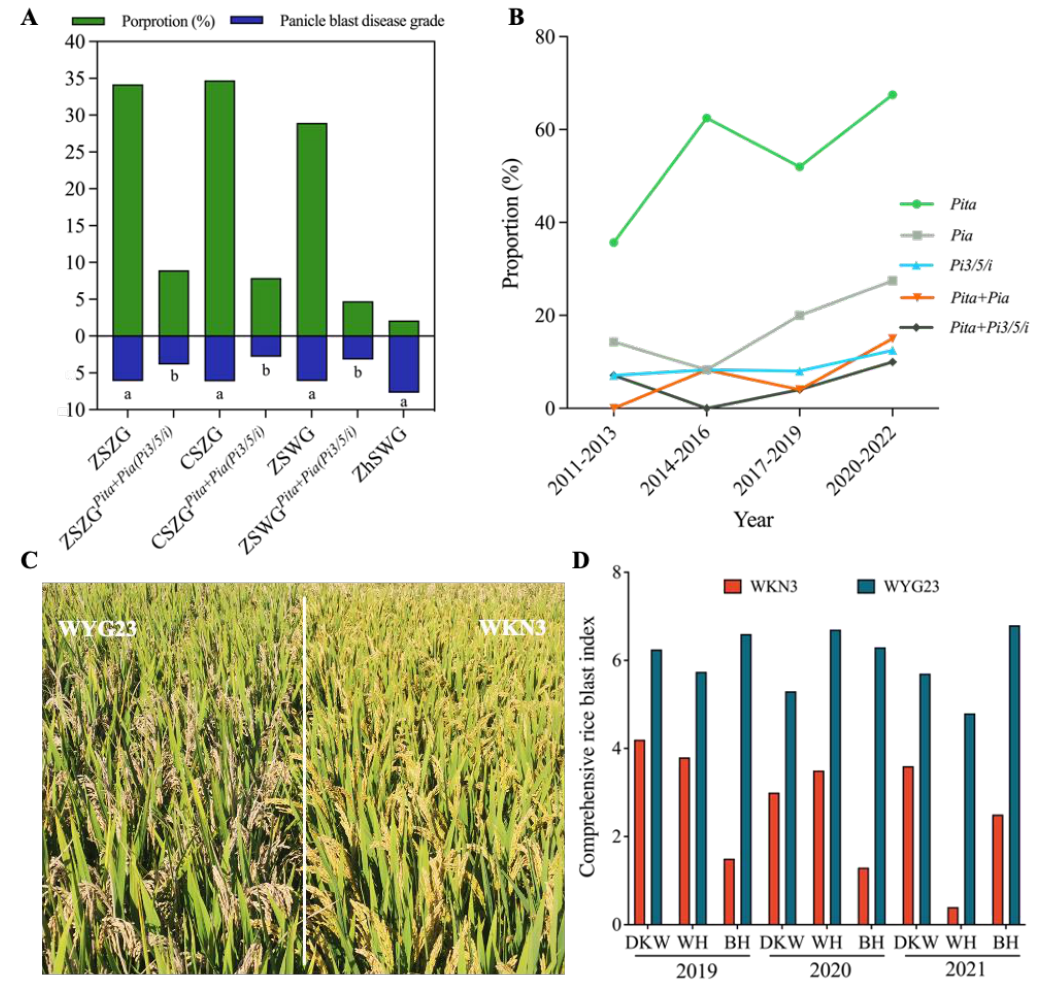
Figure 5. Application of core R genes and gene combinations in Jiangsu Geng varieties in recent years. ( A ) Application of Pita + Pia ( Pi3/5/i ) in varieties of different ecotypes tested for panicle blast resistance. Green columns denote the proportion of different ecotypes among the tested varieties, and blue columns represent the average panicle blast disease grades of different ecotypes. Different lowercase letters indicate significant differences according to Duncan ’s multiple range tests ( p < 0.05). ( B ) Distribution of 3 core R genes and 2 core R -gene combinations in Jiangsu Geng varieties at different annual intervals. ( C ) Panicle blast resistance performance of WNK3 in a blast nursery.